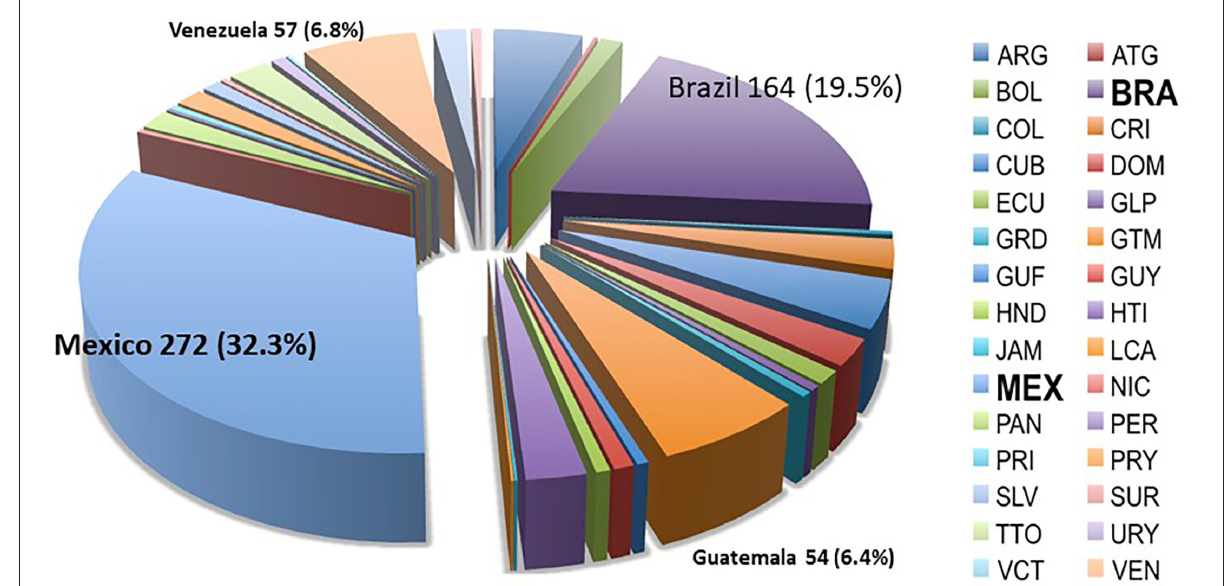
FIGURE1 Accessions in the TSC GWAS (genome-wide association study) panel by country of origin. The panel consists of maize landrace accessions collected from 30 different countries with the majority coming from Mexico (32.3%) and Brazil